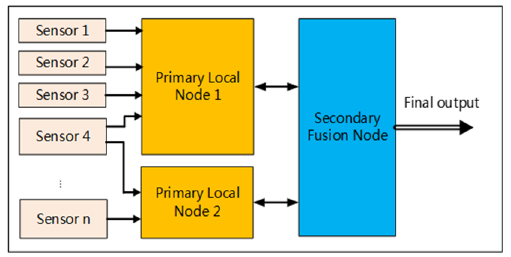
Figure 1. Hybrid fusion mode. The system consists of primary local nodes and a secondary fusion node.